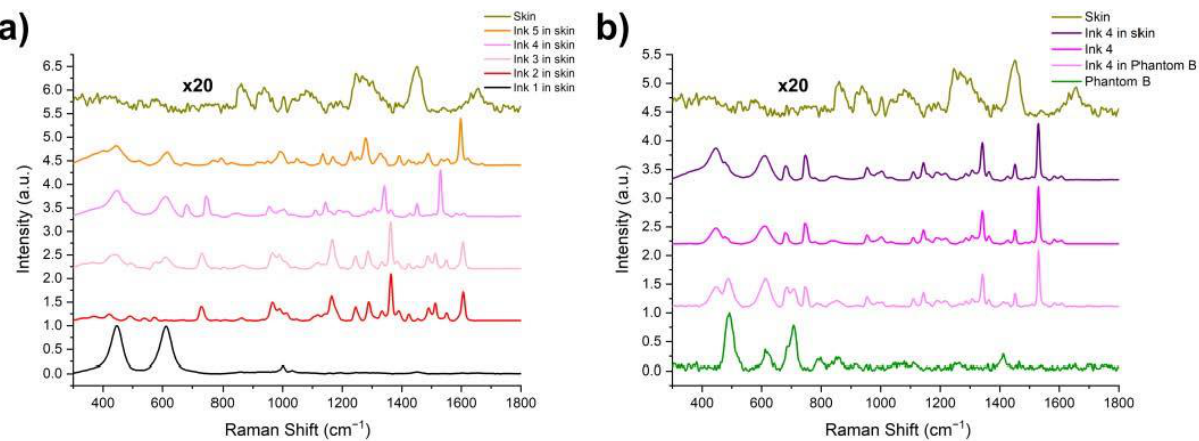
Figure 5. ( a ) Pre-processed Raman spectra of Inks 1–5 tattooed in porcine skin and the spectrum of pure porcine skin. ( b ) Comparison between the pure porcine skin and pure Phantom B spectra, as well as comparison between Ink 4 in Phantom B, reference spectrum of Ink 4, and Ink 4 in the porcine skin.